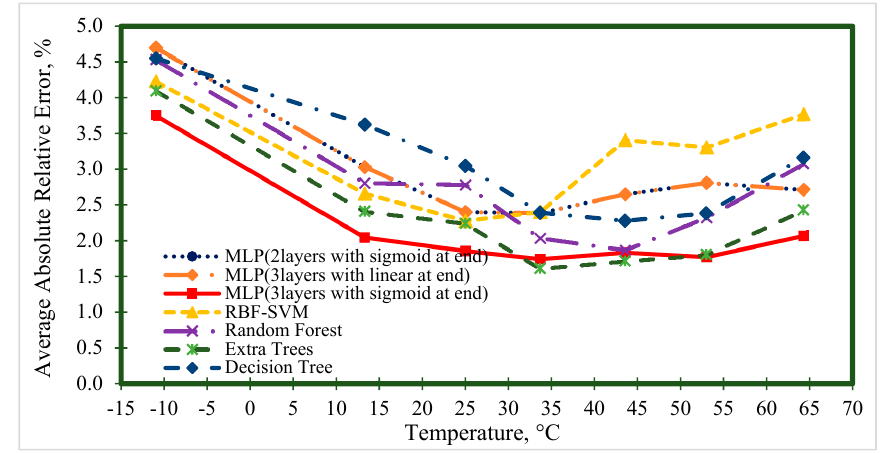
Figure 6. Average absolute relative error at different temperature ranges for prediction of the viscosity of nanofluids. Nanomaterials 2020 , 10 , x FOR PEER REVIEW